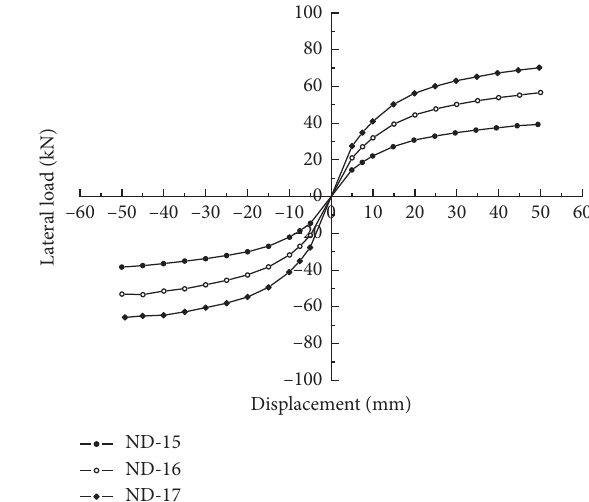
Figure 17: Skeleton curves of slit width 5mm. Figure 18: Skeleton curves of slit width 100